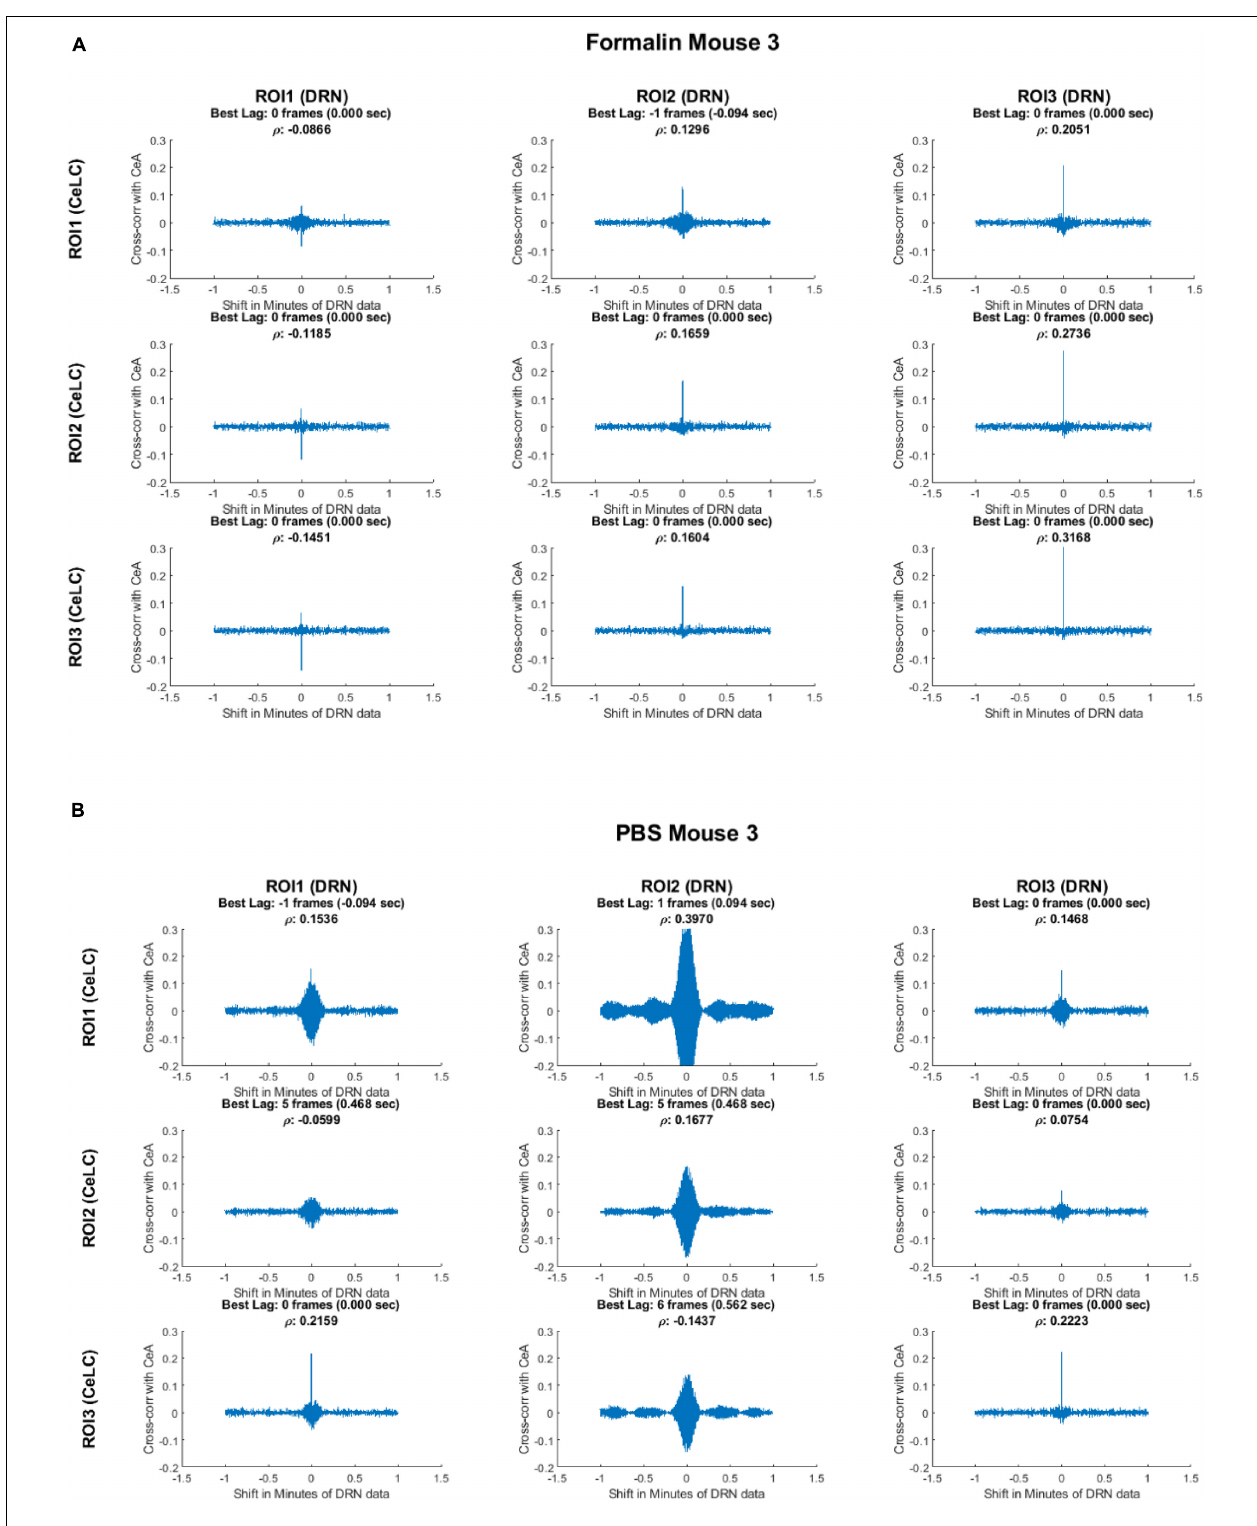
FIGURE 8 | Cross-correlation analysis of two representative mice. Top: Formalin-injected mouse; bottom: PBS-injected mouse. The figure shows the cross-correlation of the first-difference of CeLC fluorescence imaging data with DRN data. The correlation between CeLC and time-shifted DRN (across varying lags) is measured. Peaks indicate high cross-correlation at that specific shift or time lag of the DRN data. The time lag with the highest cross-correlation coefficient ( ρ ) is indicated at the top of each graph.